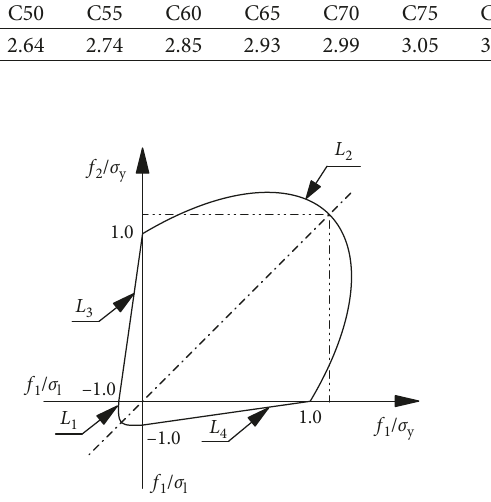
Figure 7: Strength envelope diagram of biaxial stress in concrete.